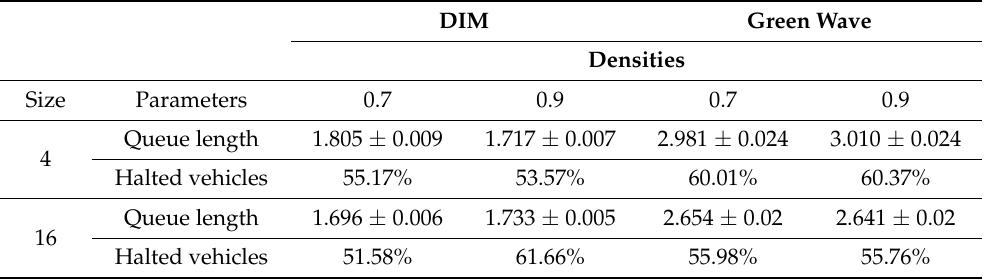
Table 1. Queue lengths and halted vehicles in cities with 200 meters between intersections.